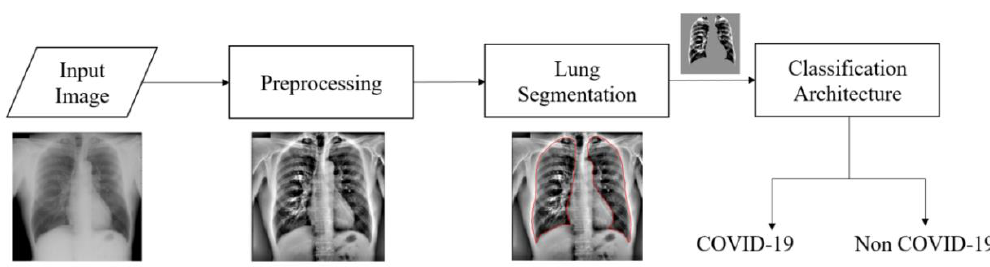
Figure 7. Top-level block diagram of enhanced baseline and recommended Computer-Aided Detection (CAD) systems for COVID-19 in chest radiographs.